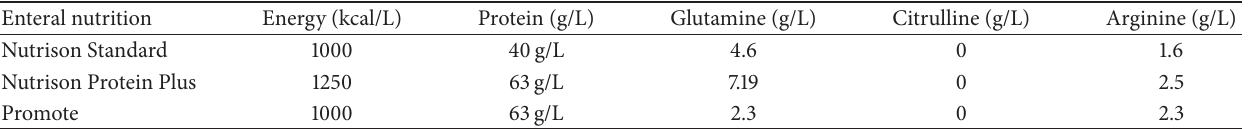
Table 1: Enteral nutrition.